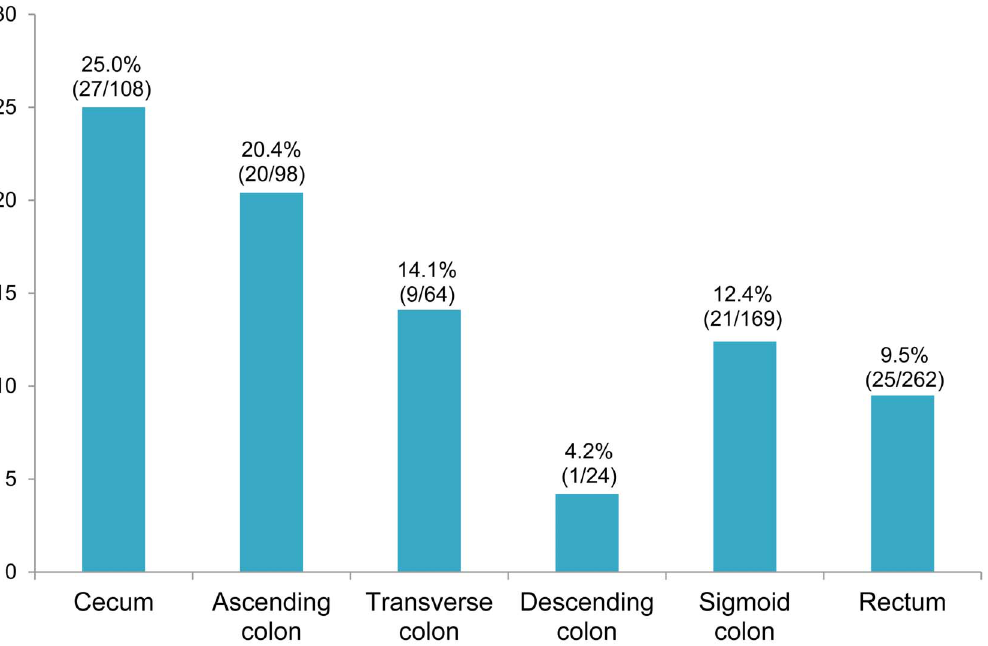
Figure 1. Proportion of PIK3CA mutation in colorectal carcinomas from each segment of the large bowel.